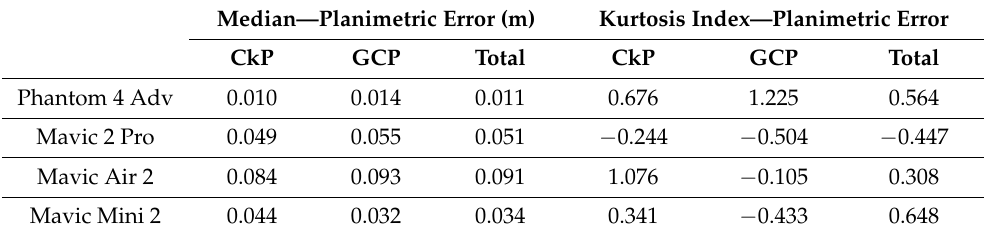
Figure 13. Chart of the residuals on GCPs and CkPs of the four UASs (Altimetric). Table 8. Median calculated for the planimetric error.